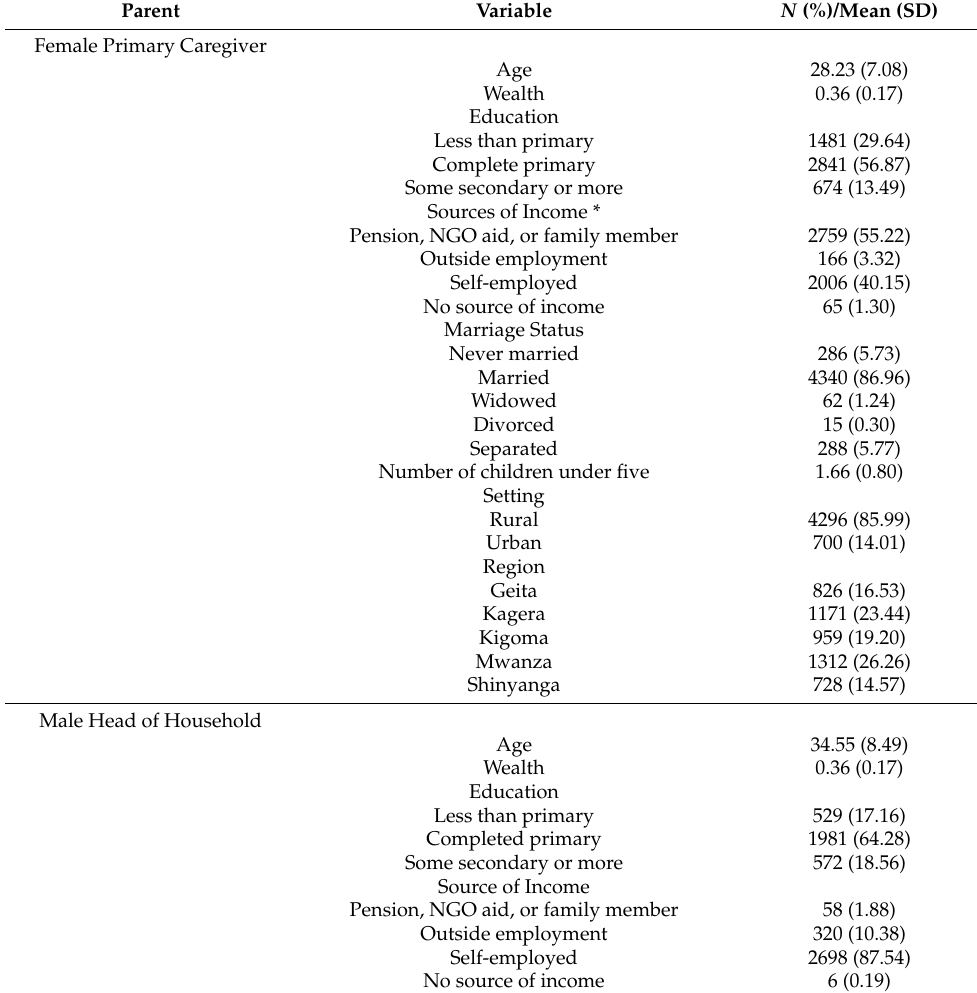
Table 1. Participant